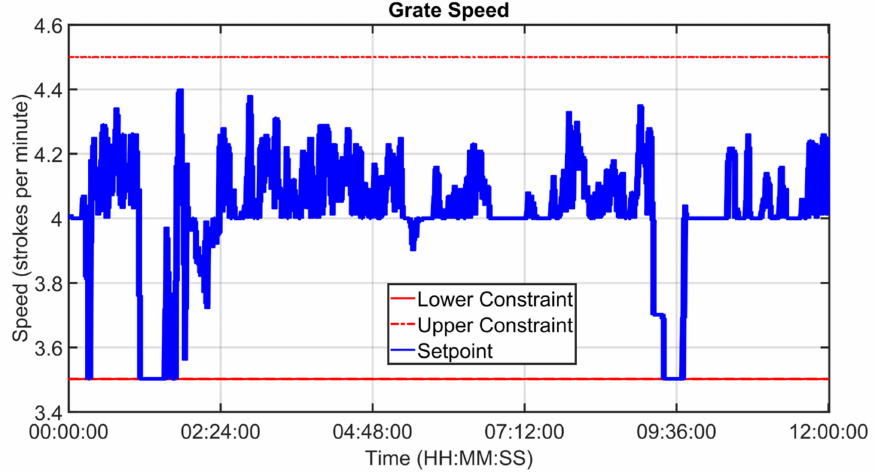
Figure 29. Grate cooler APC system: field results (grate speed MV).